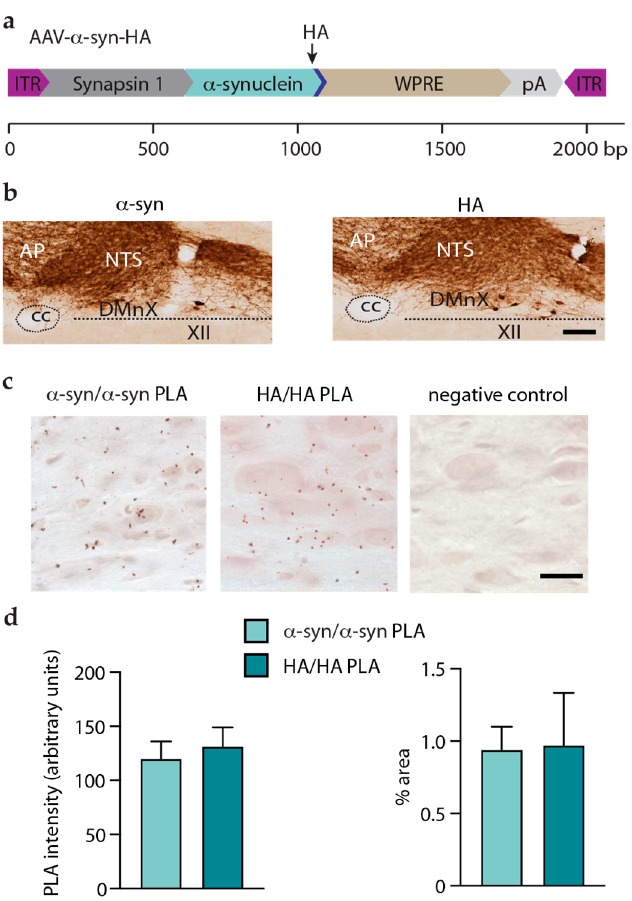
Figure 4. AAV-induced expression and aggregation of α -syn in the dMO. Mice received an injection of AAV- α -syn-HA into the left vagus nerve and were sacrificed 6 weeks after surgery. ( a ) Vector design of AAV- α -syn-HA. The scale bar displays the size (base pair, bp) of each genetic component. ( b) Representative images of coronal sections of the medulla oblongata that were stained either with an antibody specific to human α -syn or with anti-HA. Scale bar: 100 μ m. ( c ) Coronal sections of the medulla oblongata were processed for either α -syn/ α -syn or HA/HA PLA. Representative images show specific PLA labeling (reddish brown) in the DMnX. No labeling was instead detected in negative control sections in which one of the HA/HA PLA probes was omitted. Scale bar: 10 μ m. ( d ) Image analyses were carried out in the left (ipsilateral to AAV injections) dMO and measured the intensity of the PLA signal (left panel) and the percentage of the area occupied by this signal (right panel). Unpaired t -test, t 4 = 0.48, p = 0.90 (left panel) and t 4 = 0.08, p = 0.32 (right panel). Abbreviations: XII: nucleus of the hypoglossal nerve; AP: area postrema; cc: central canal; DMnX: dorsal motor nucleus of the vagus nerve; ITR: inverted terminal repeat; NTS: nucleus tractus solitarius; pA: polyA; WPRE: woodchuck hepatitis virus posttranscriptional regulatory element.